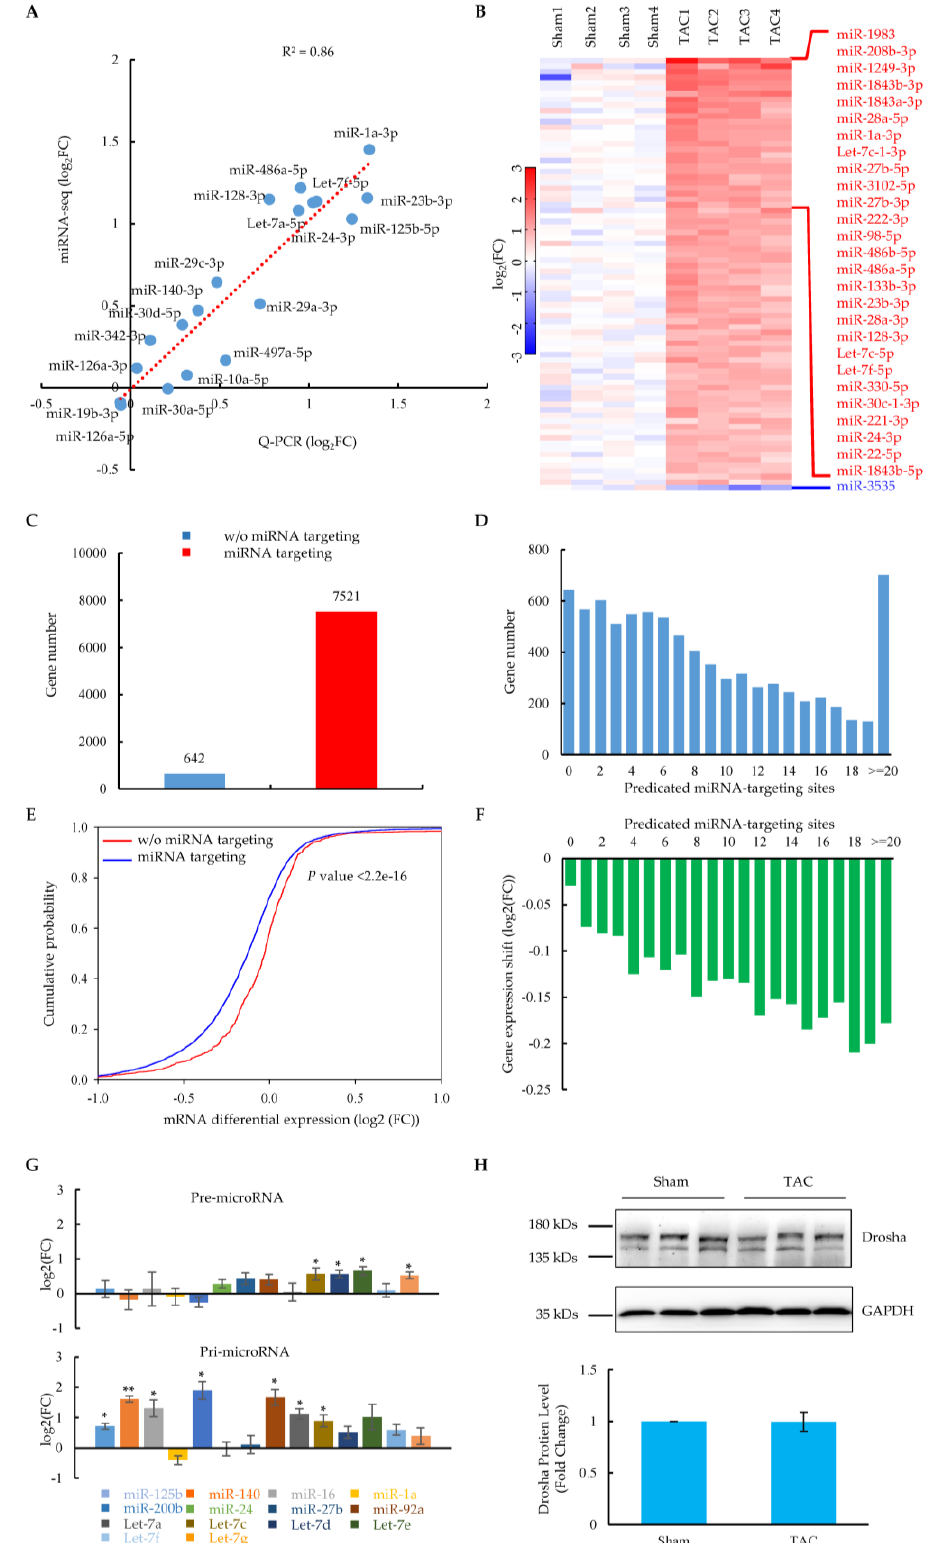
Figure 2 . Signature of miRNA expression and their regulation on mRNAs in cardiomyocytes at the heart failure stage. ( A ) QPCR validation of the expression of 19 miRNAs from miRNA global pro- filing. The red dotted line shows the correlation of QPCR results with miRNA-seq. ( B ) Heatmap of significantly changed miRNAs ( p -value < 0.05, fold change > 1.70) from miRNA-seq (in quadrupli- cate) in cardiomyocytes of sham and TAC mice. Results were sorted by the average of the fold change. Red indicates increased expression; blue indicates decreased expression. The 27 most